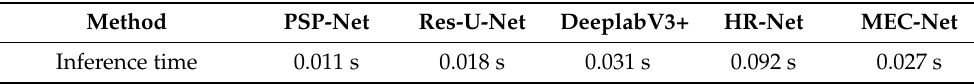
Figure 14. FLOPs for each model and their IoU with the three datasets. Table 9. Inference time for a single image slice for the models.